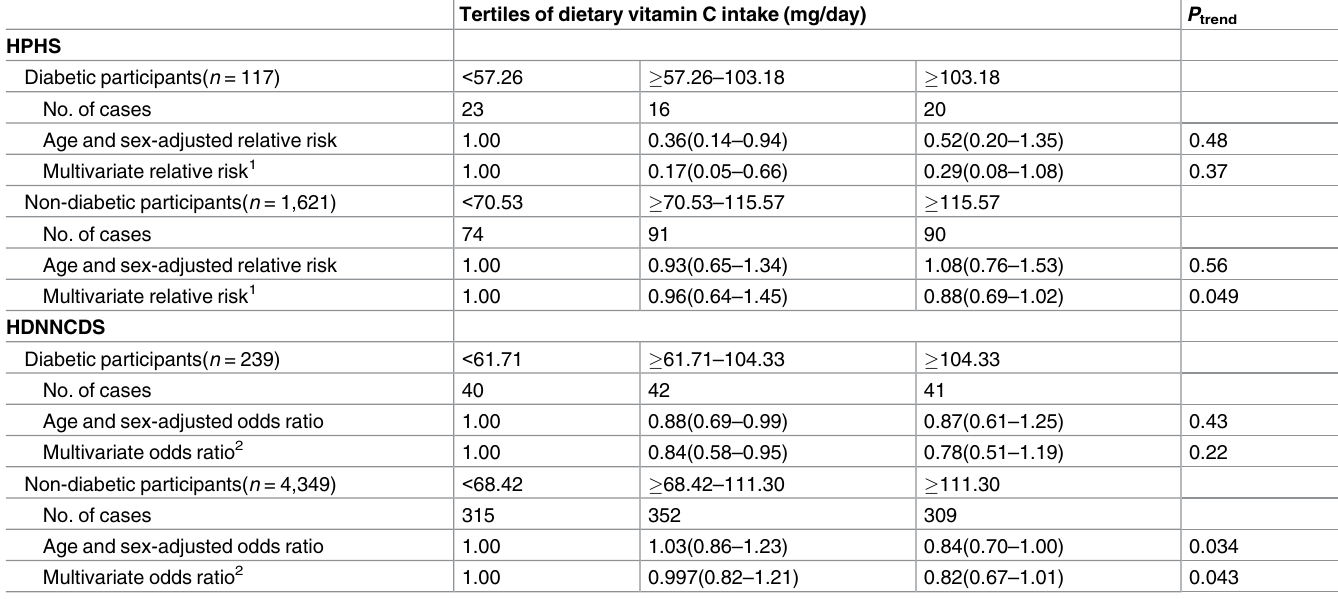
Table 3. Adjusted relative risks (RRs) (and 95% confidence intervals) of insulin resistance across tertiles of dietary vitamin C intake in the Harbin People’s Health Study (HPHS, 2008–2012) and in the Harbin Cohort Study on Diet, Nutrition and Chronic Non-communicable Diseases (HDNNCDS,